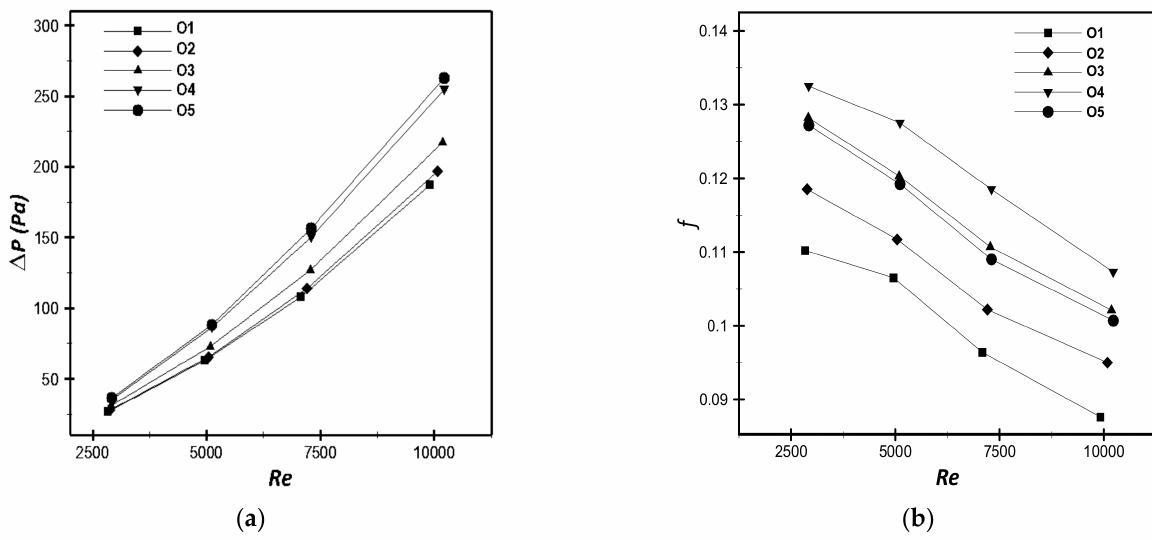
Figure 9. Comparison of oval tube shapes at varying Reynolds number: ( a ) Pressure drop; ( b ) friction